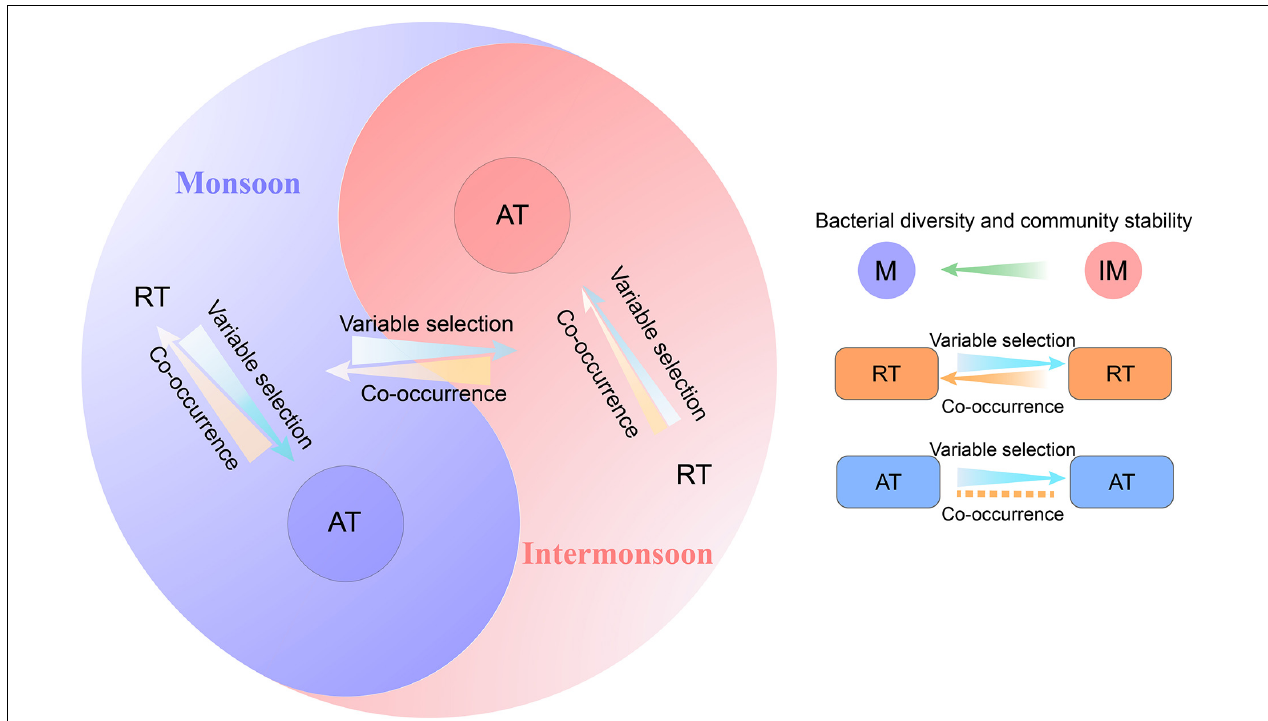
FIGURE 6 | A conceptual paradigm showing the linkage between assembly process and co-occurrence pattern of rare and abundant bacterial